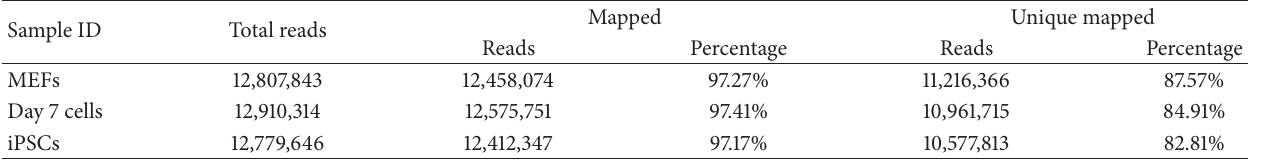
Table 2: Mapped reads output from H2A.Z